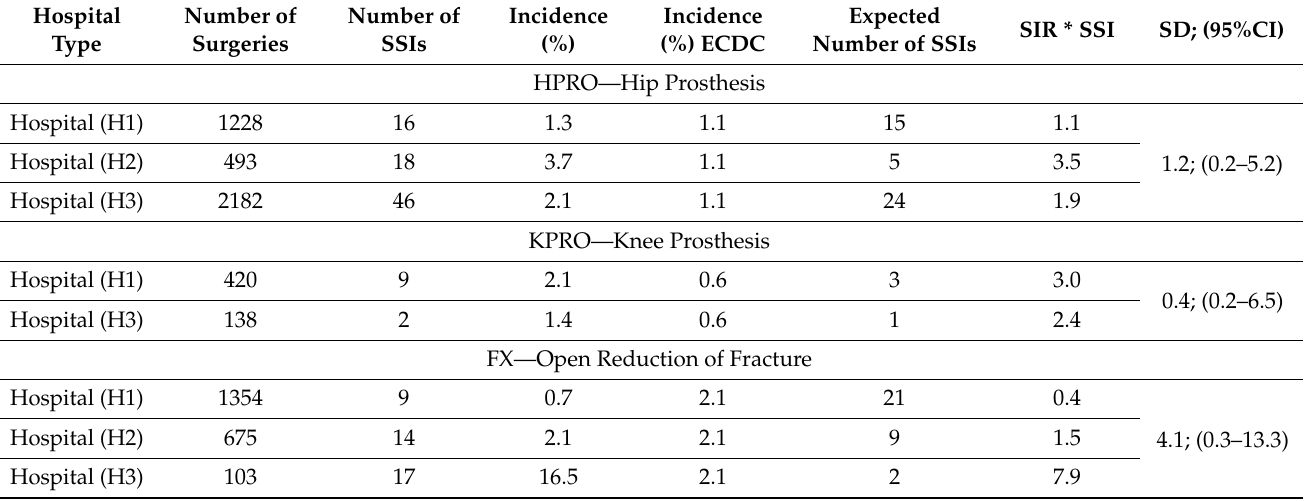
Table 3. Incidence of SSI for HPRO and KPRO divided into three orthopaedic hospitals in comparison to ECDC 2017 [14] and FX-NHSN [15] considering risk factors in